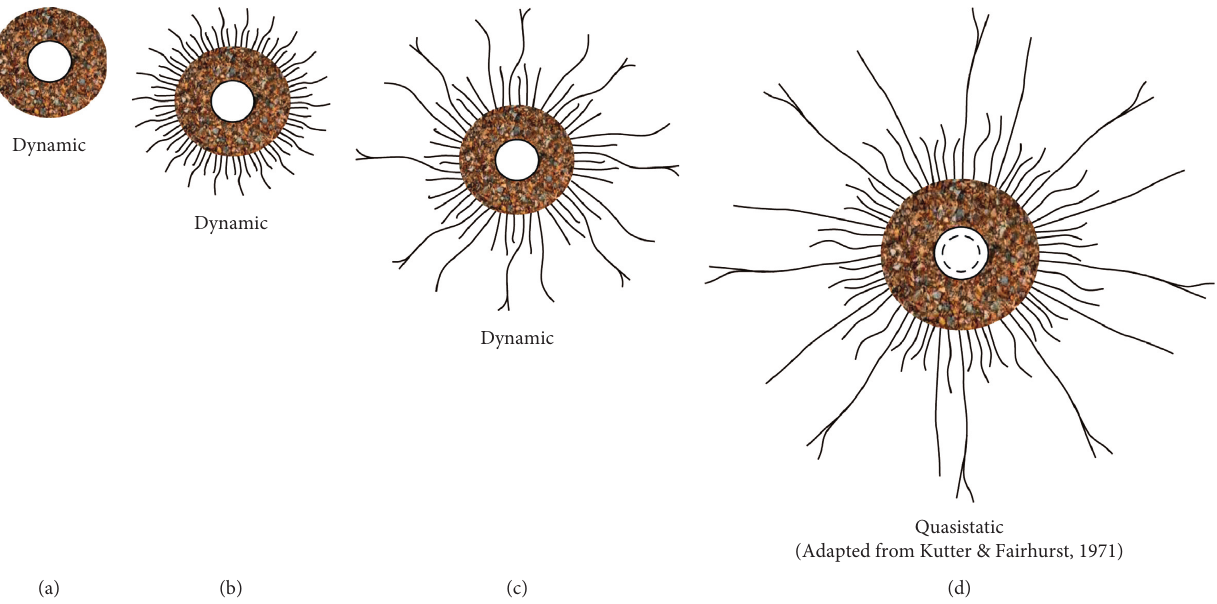
Figure 1: Consecutive stages in the cracking process of rock blasting [7]: (a) crushing zone; (b) crushing and fracture in the nonlinear zone; (c) radial cracks from an elastic wave; (d) expansion of cavity, extension of nonlinear crushed zone, and growth of radial fractures.